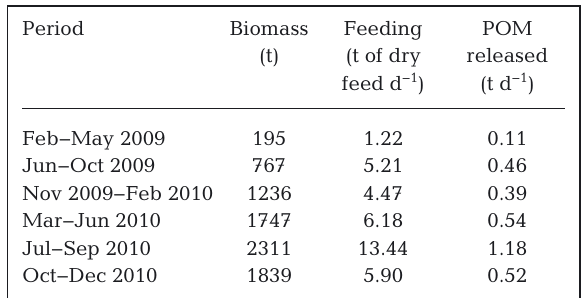
Table 1. Maximum standing biomass, average feeding rates and estimated release of particulate organic waste (POM) over the production cycle. POM release rates are based on Brooks & Mahnken (2003) and suggest that faecal discharge corresponds to 8.8% of organic matter delivered via fish